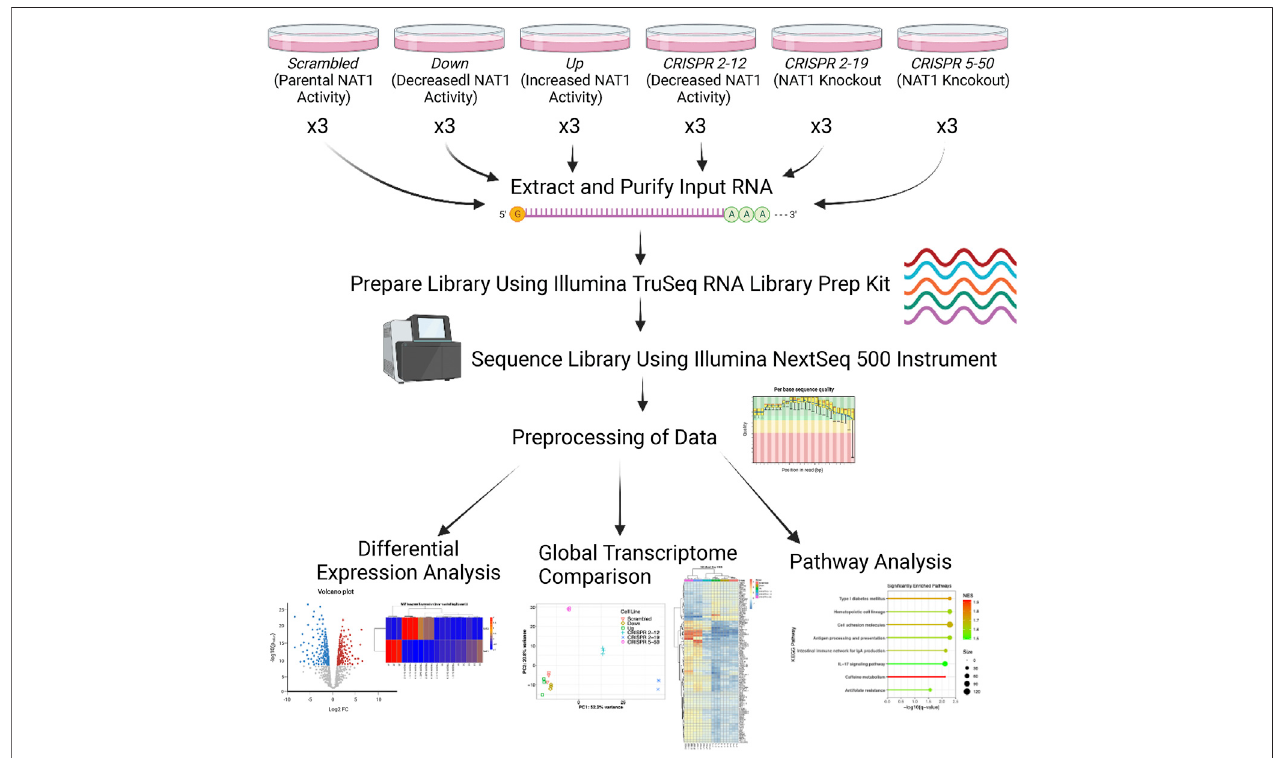
FIGURE 1 | Transcriptomics Experimental Approach. Three biological replicates were collected for each cell line, RNA was extracted and puri fi ed, and libraries wereprepared using the inputRNA.Oncelibrarypreparation wascomplete, librariesweresequenced usingthe IlluminaNextSeq 500instrument.Resultingsequencing data were aligned to the hg38 human reference genome via STAR and read counts were generated for each gene using the Bioconductor R package GenomicAlignments. Next, differential expression analysis, PCA, hierarchical clustering, and pathway analysis was performed.